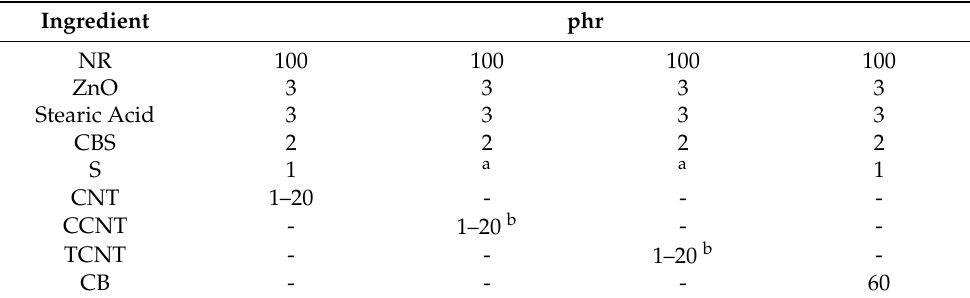
Table 1. Formulation of the rubber